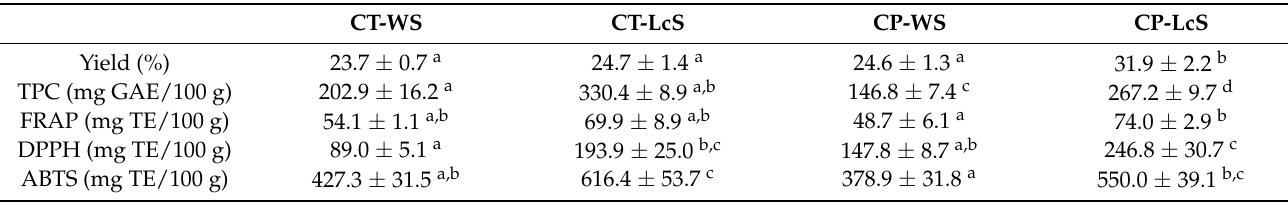
Table 3. Summary of the mean values * ± standard deviation ( n = 3) obtained for yield, TPC, FRAP, DPPH and ABTS for P. ostreatus